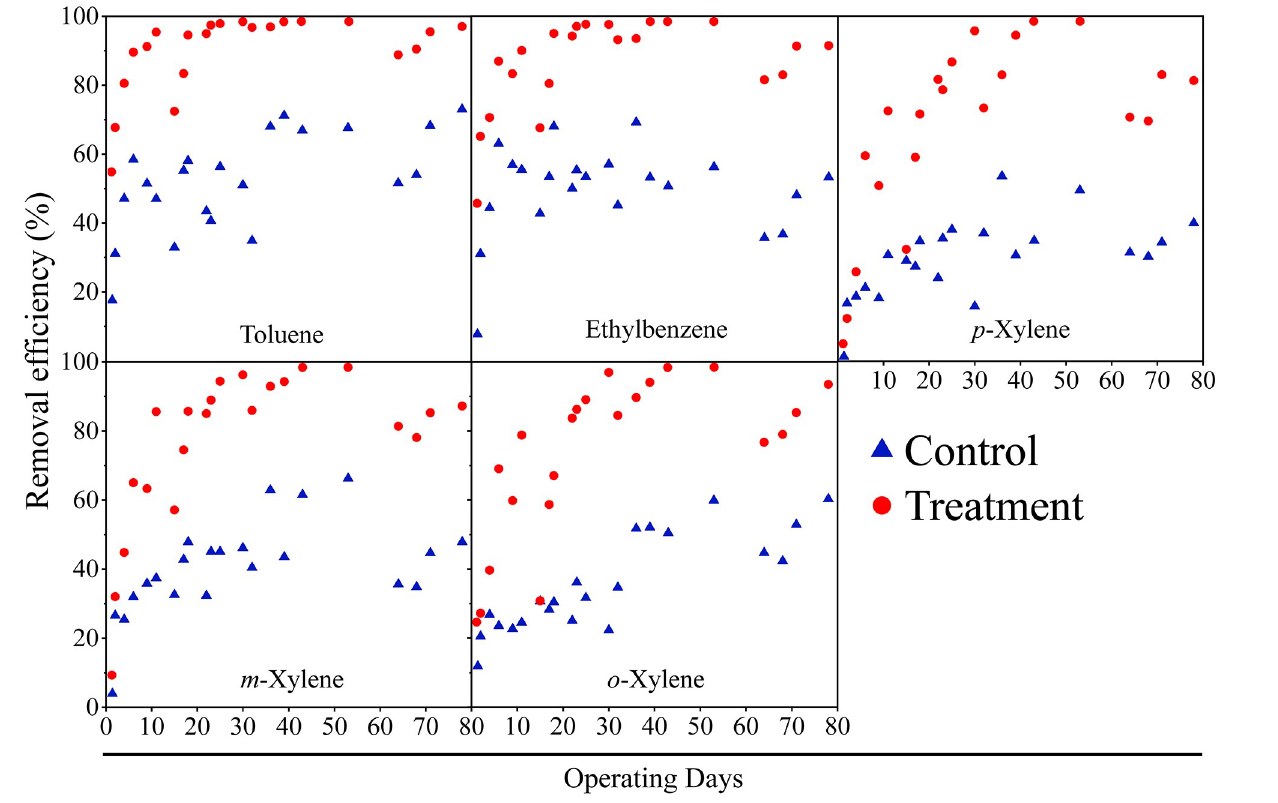
Fig 1. Removal efficiency of the five aromatic compounds in the two